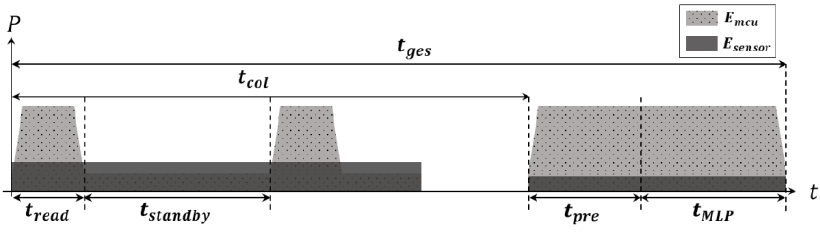
Figure 6. Visualized energy consumption over the time.